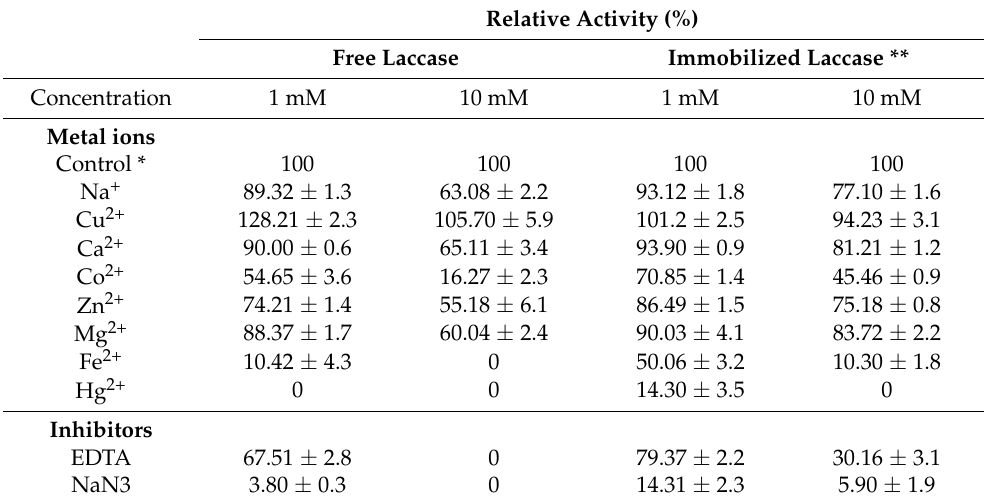
Table 2. Effect of metal ions and inhibitors on the activity of free and immobilized Tt LacA. Relative Activity (%)